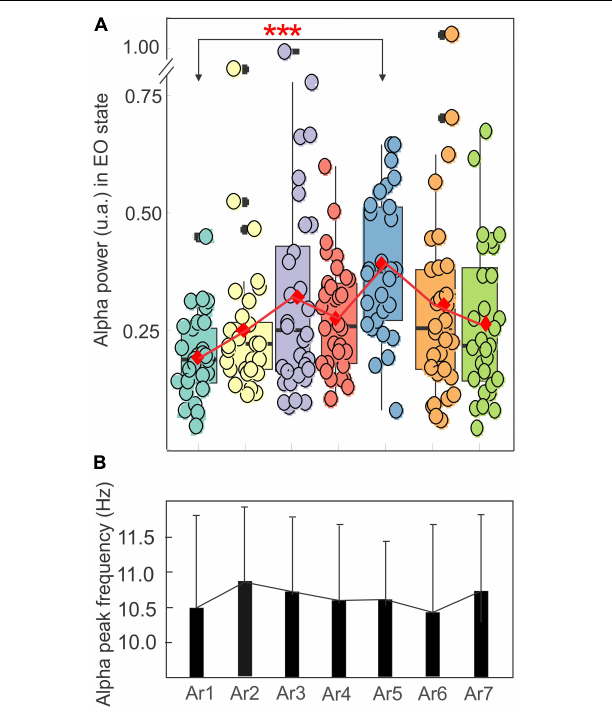
FIGURE 5 | Evolution of the mean ± SD of the power in a box plot configuration (A) and of the frequency peak (B) of the alpha rhythm with the eyes open from AR1 (control before the RB session) to AR7, in the eight subjects who showed an increase of the alpha oscillation for at least one AR testing